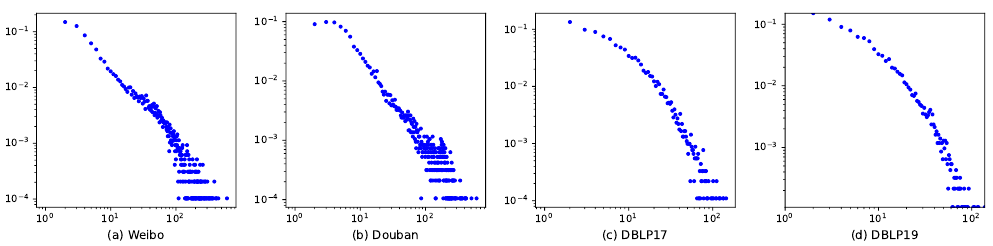
Figure 3. The degree distributions of our experimental data